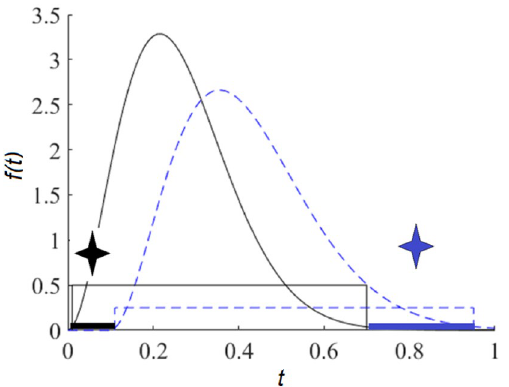
Figure 1. Manne condition in a concentration space. Here, f ( t ) is the concentration of one component (solid line) and another component (dotted line). The function carriers are shown as rectangles. According to the Manne condition, the function carriers should not completely overlap. Here, the black star corresponds to the area of evolutionary variable t , where the “black” component can be analyzed without the influence of the “blue” component. The opposite situation is marked with a blue